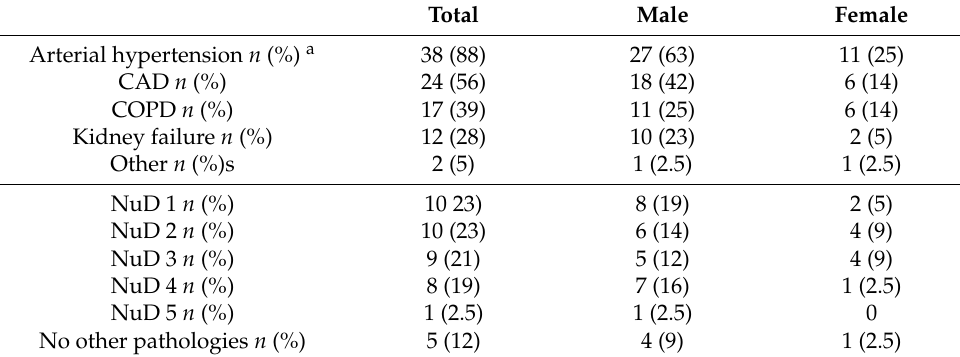
Table 3. DFUs and population